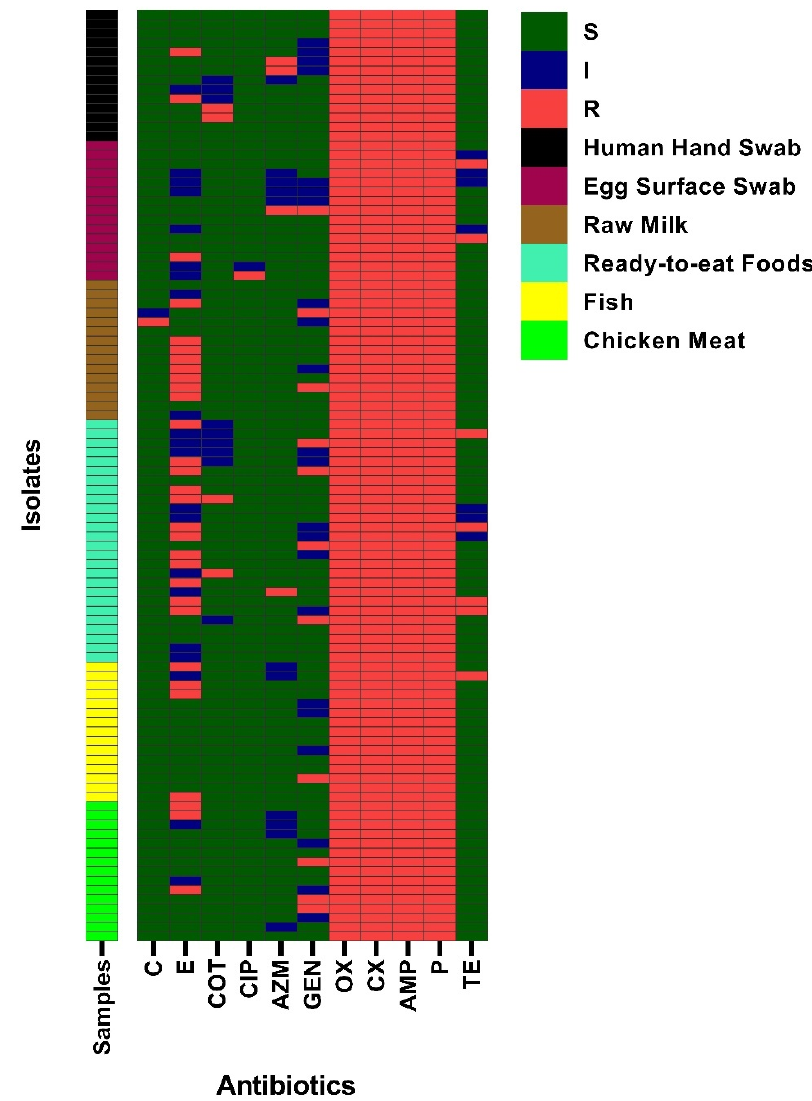
Figure 1. Antibiogram profiles of biofilm-forming S. aureus isolated from different foods and human hand swab samples. C = Chloramphenicol, E = Erythromycin, COT = Co-trimoxazole, CIP = Ciprofloxacin, AZM = Azithromycin, GEN = Gentamicin, OX = Oxacillin, AMP = Ampicillin, TE = Tetracycline, P = Penicillin, CX = Cefoxitin, S = Sensitive, I = Intermediate, and R = Resistant.